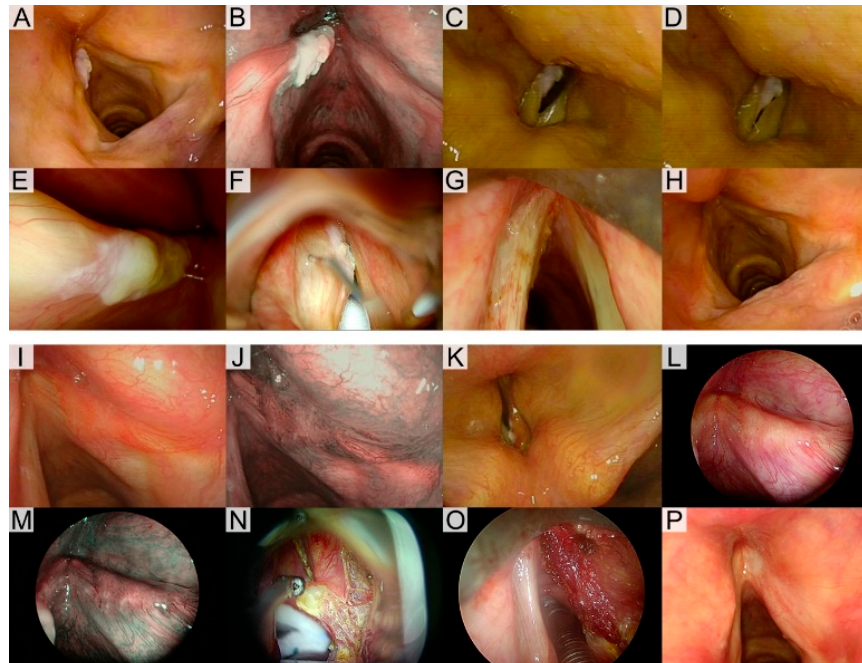
Figure 1. The application of the diagnostic workup. ( A – H ) Case 1. Preoperative white light (WL) videoendoscopy ( C ) showing a left mid-cord leukoplakia without narrow band imaging (NBI) vascular abnormalities ( B ). Mucosal wave was not impaired at videolaryngostroboscopy (VLS) ( C , D ).